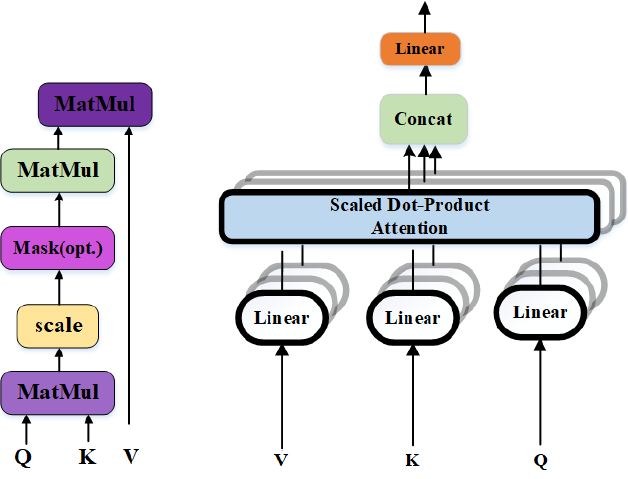
Figure 5. Scaled dot product attention and multi-head